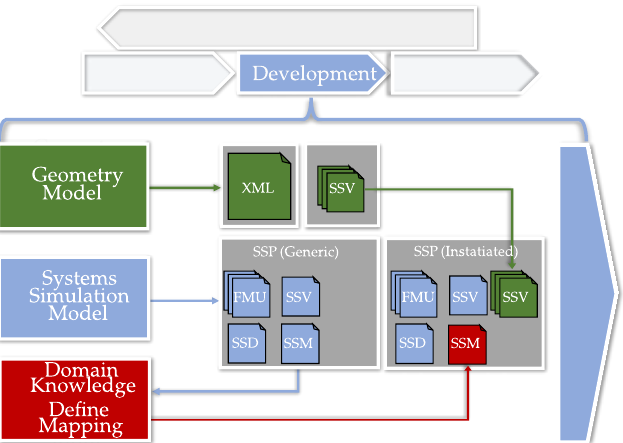
Figure 2. Expansion of the development activity specified in Figure 1. The workflow is designed to be applicable to the three system levels shown in Figure 1: the Component Model, Sub-System Model, and Simulator levels of abstraction. The colors in the figure indicate the source of the information. The rightmost SSP in the figure, SSP (Instantiated ), conforms to an executable specified using information from all the relevant engineering